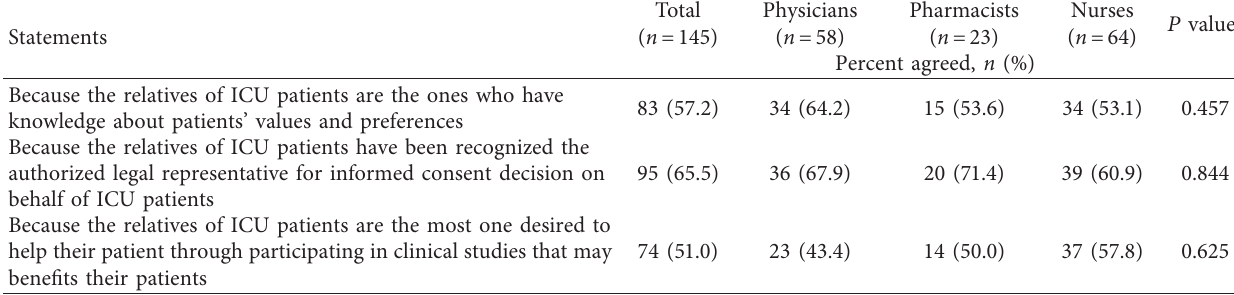
Table 3: Healthcare providers’ perception towards obtaining the proxy consent for clinical research from relatives for ICU patients ( n � 145).